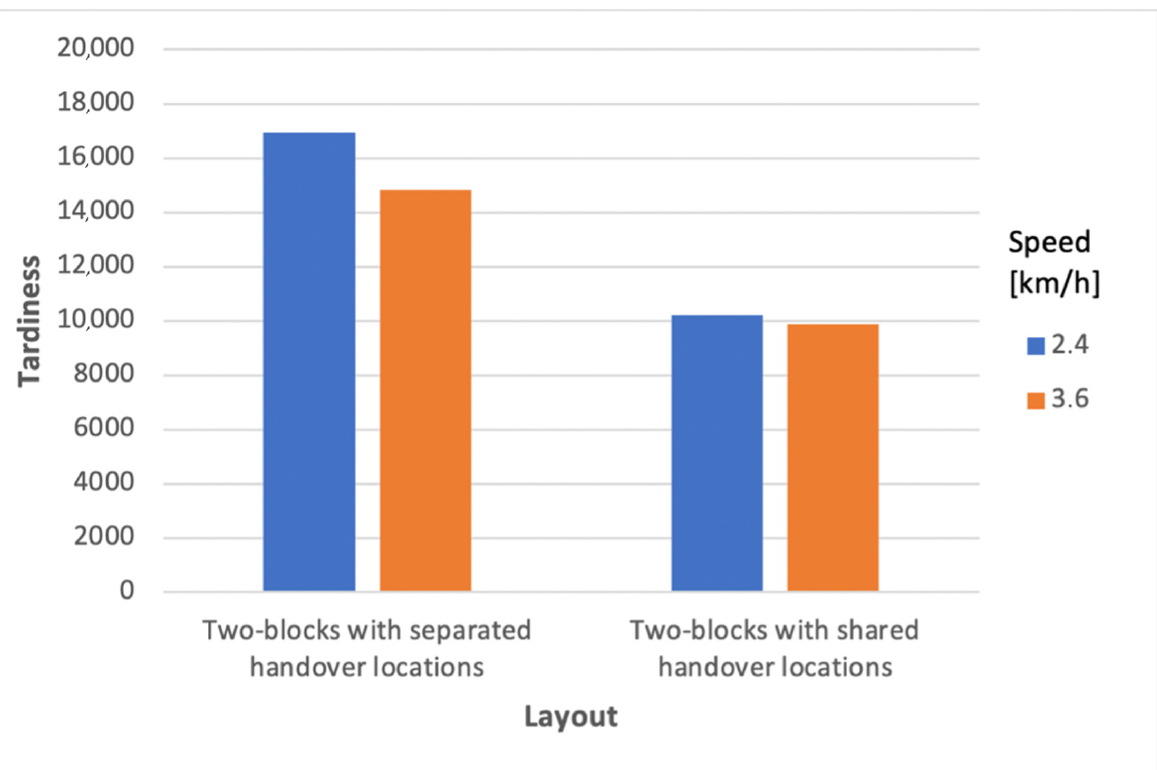
Figure 7. Tardiness values for increasing fleet sizes.